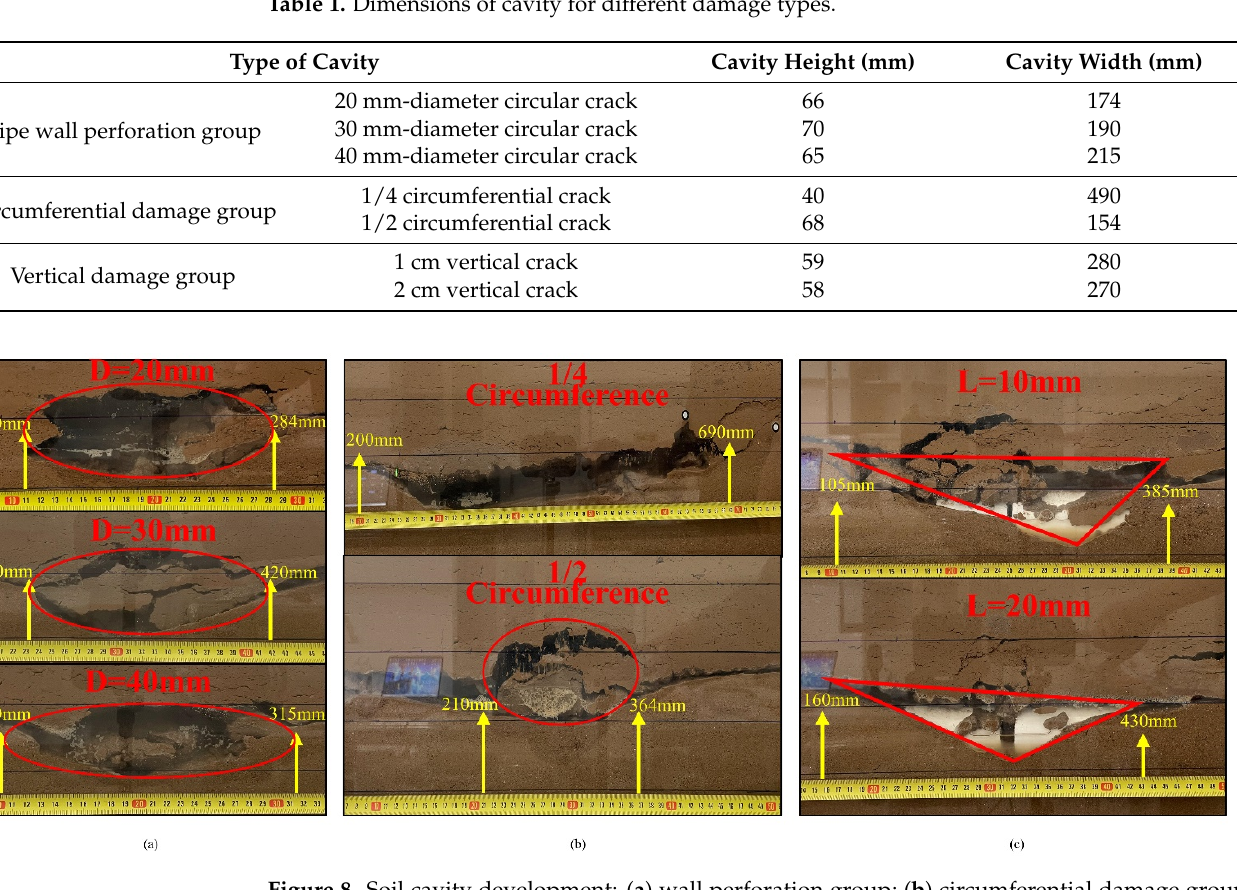
Figure 8. Soil cavity development: ( a ) wall perforation group; ( b ) circumferential damage group; ( c ) vertical damage group (yellow font for scale reading).